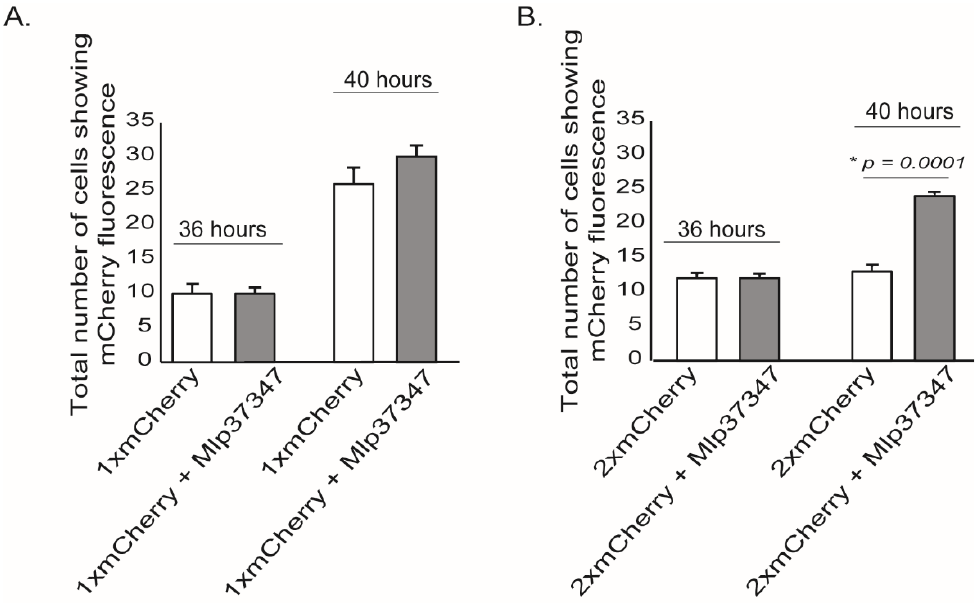
Figure 1. Mlp37347 enhances plasmodesmata flux. ( A ) Quantification of 1 × mCherry diffusion to surrounding cells with or without the effector provided a measure of molecular flux through plasmodesmata. ( B ) Quantification of 2 × mCherry diffusion. Data represent mean ± SD. The Student’s t -test determined the statistical difference from the control leaves without Mlp37347-GFP; asterisks indicate statistical significance. Experiments were repeated three times ( N = 3).